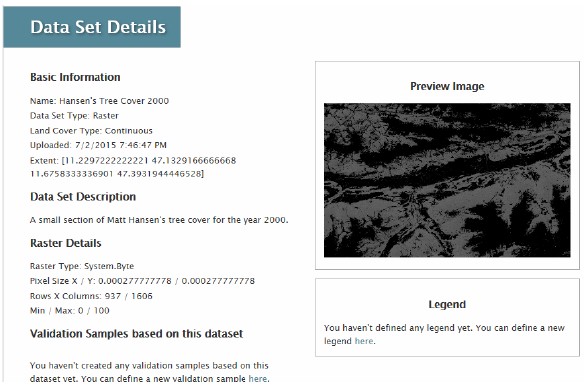
Figure 5. A page showing the details of the data set uploaded and a preview of the image